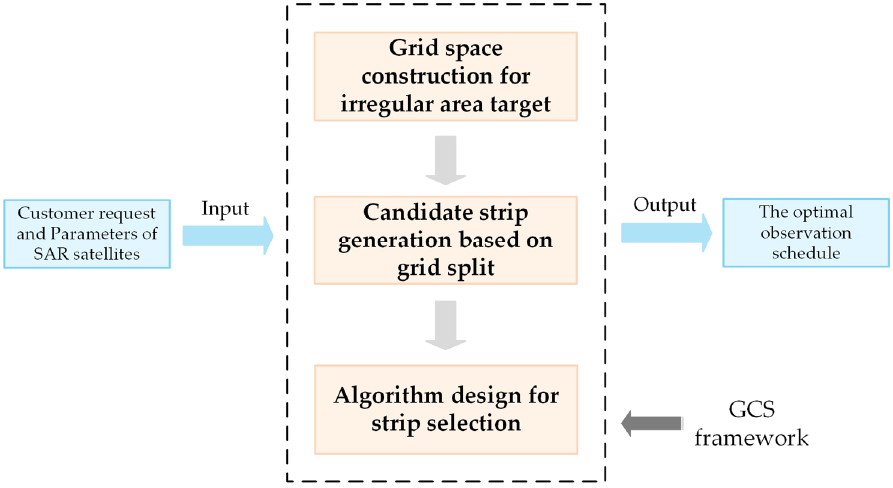
Figure 3. Main GCS framework for SMA.